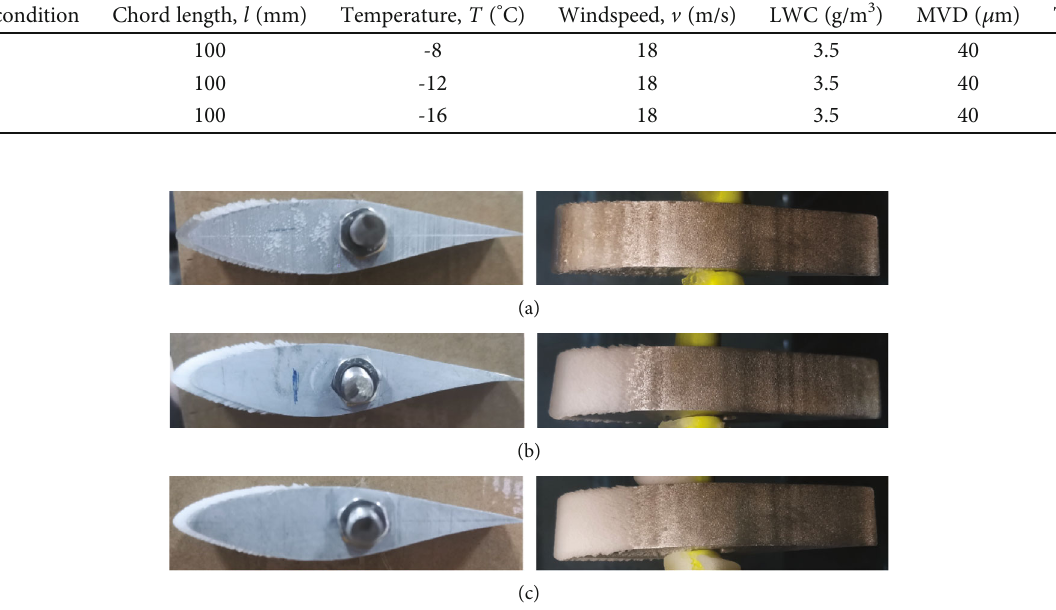
Figure 16: S809 icing shape: (a) glaze ice, (b) mixed ice, and (c) rime ice.